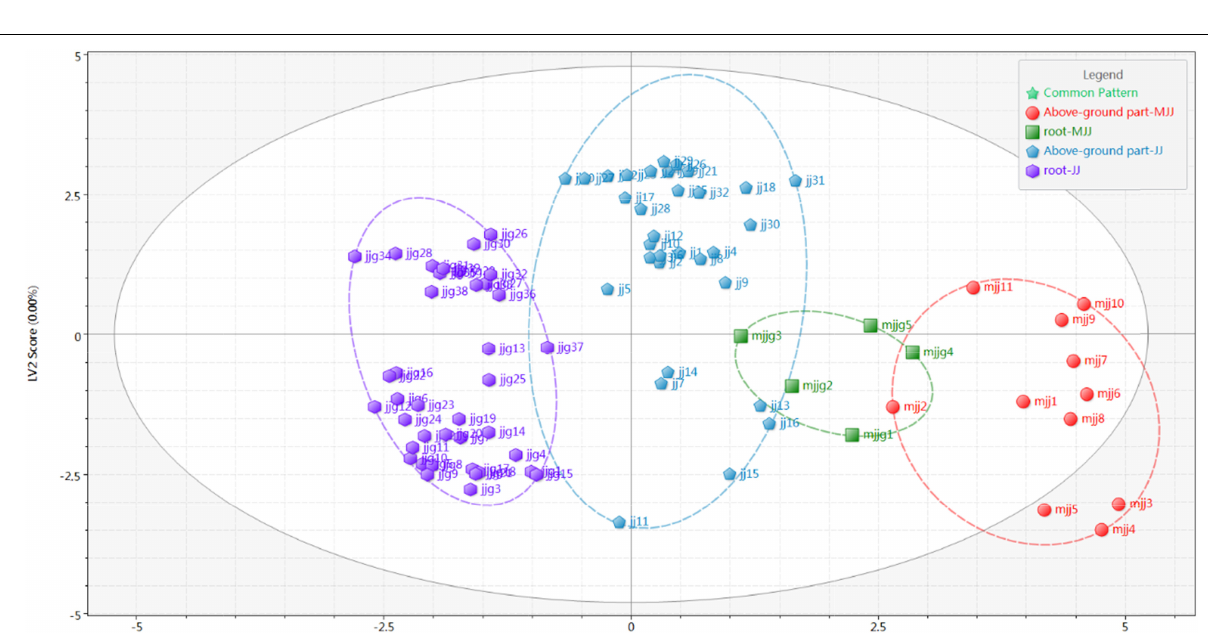
Frontiers in Nutrition |